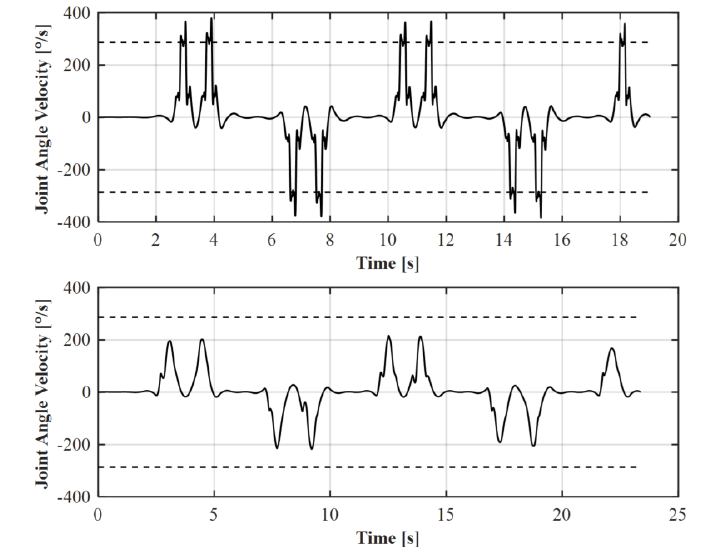
Figure 14. Change in joint velocity of 6th axis before ( top ) and after ( bottom ) trajectory